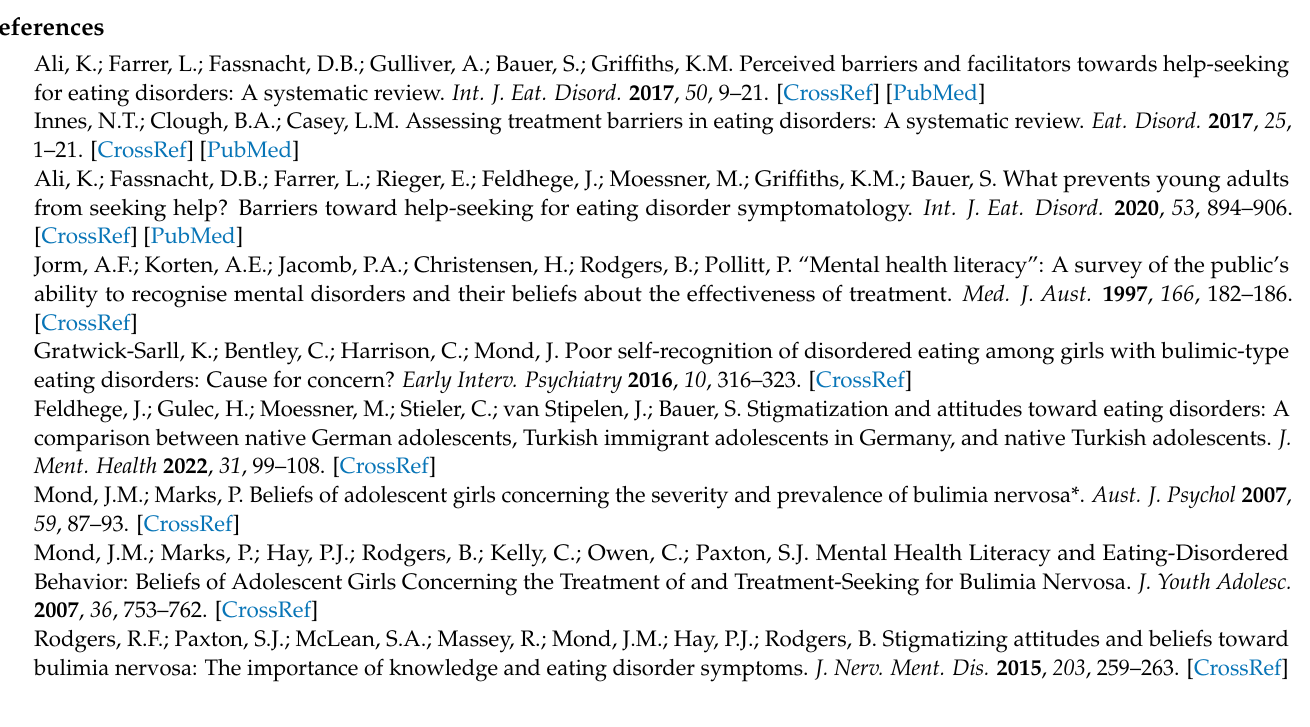
Table S2: German wording of ED-MHL